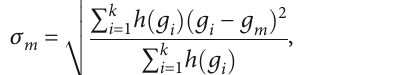
Table 1: Dual-thresholds τ